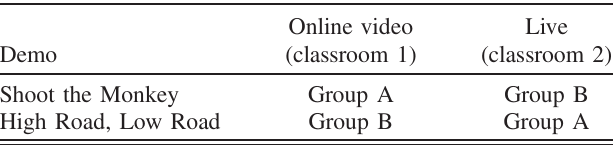
TABLE I. Randomized experimental design for the